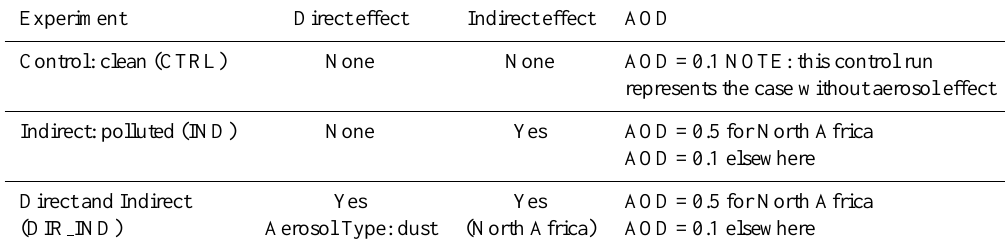
Table 1. Experiment design using D e -IWC-AOD relationship derived for North Africa region. Experiment